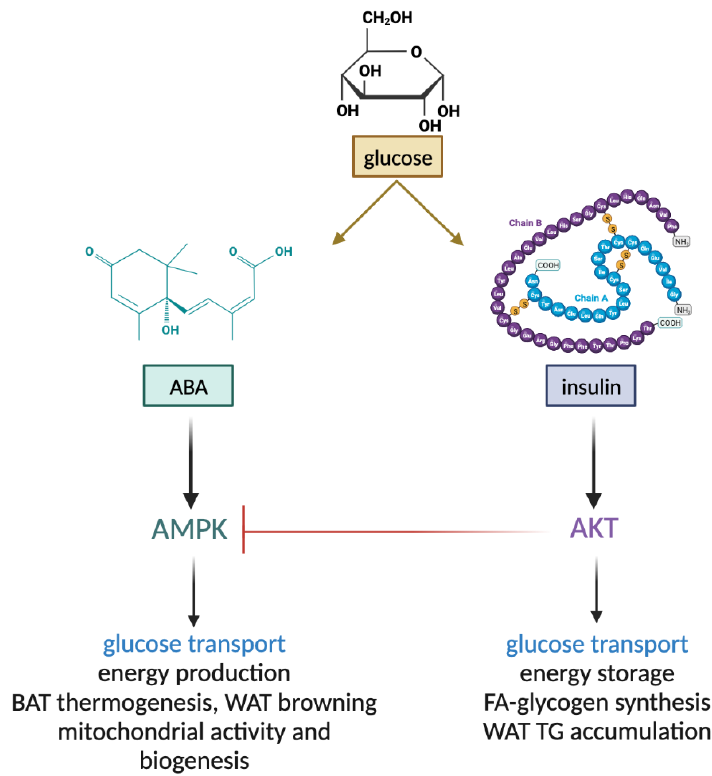
Figure 2. Non-overlapping functions of ABA and insulin in muscle and adipose tissue. ABA and insulin both stimulate glucose uptake by muscle and adipose tissue. Insulin, via Akt, stimulates the conversion of metabolic energy into storage forms, such as muscle glycogen and fatty acids and white adipocyte triglycerides. Activated Akt inhibits AMPK (blunted red line). Instead, ABA stimulates energy production via increased mitochondrial activity and biogenesis in muscle and adipose cells and thermogenesis. BAT, brown adipose tissue; WAT, white adipose tissue; FA, fatty acids; TG, triglycerides.